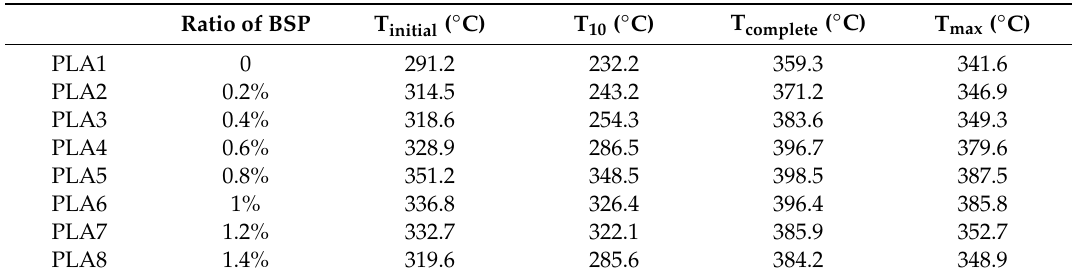
Table 3. TG and DTG data of composite films.